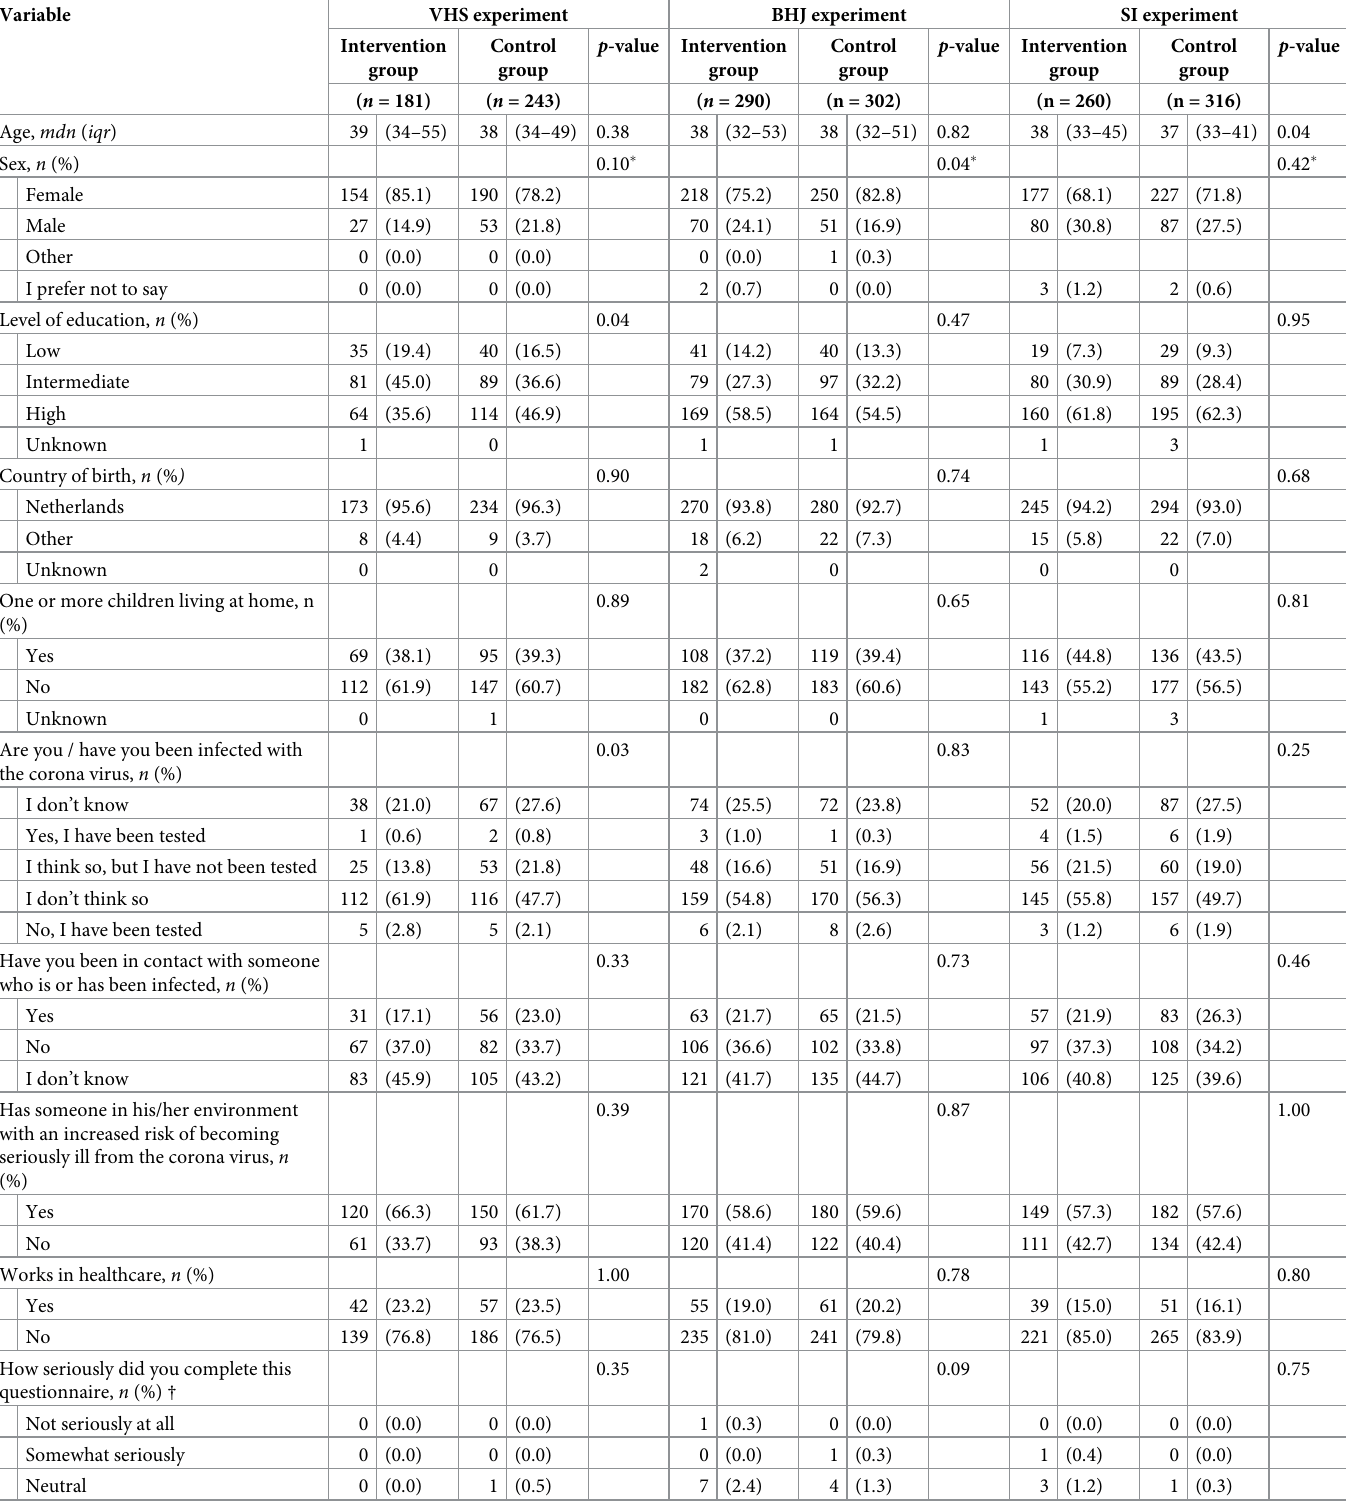
Table 1. Characteristics of participants in the three